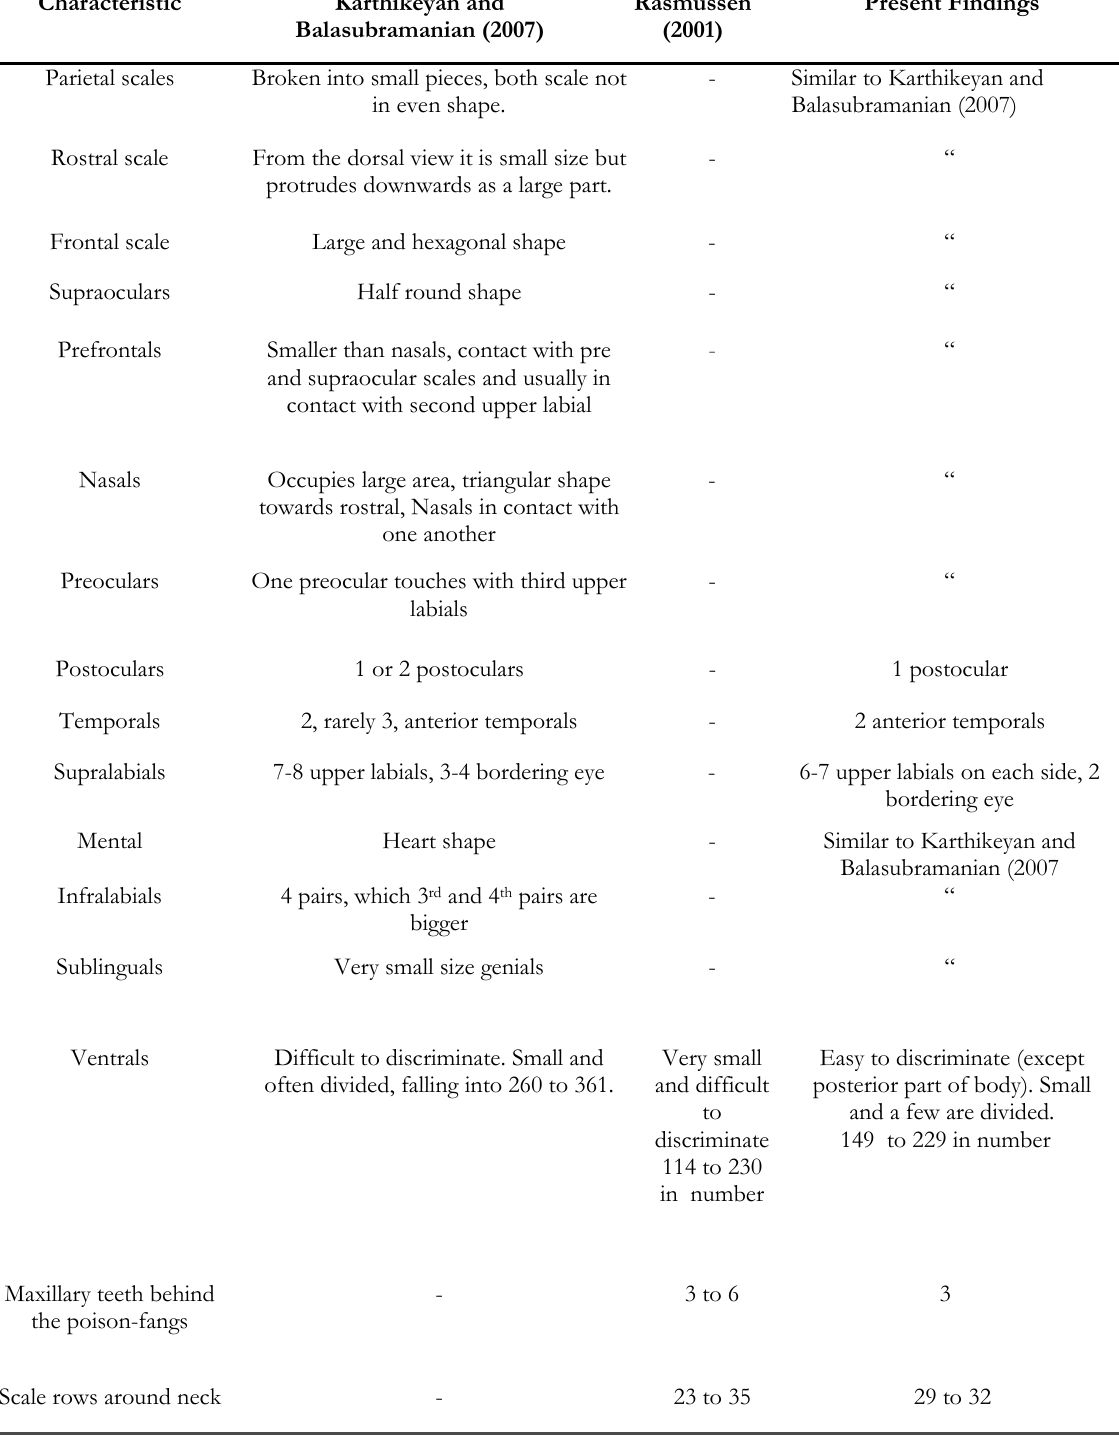
T ABLE 1. The list of discriminative morphological characteristics of L. curtus (Based on Karthikeyan and Balasubramanian (2007), Rasmussen (2001) and present findings).